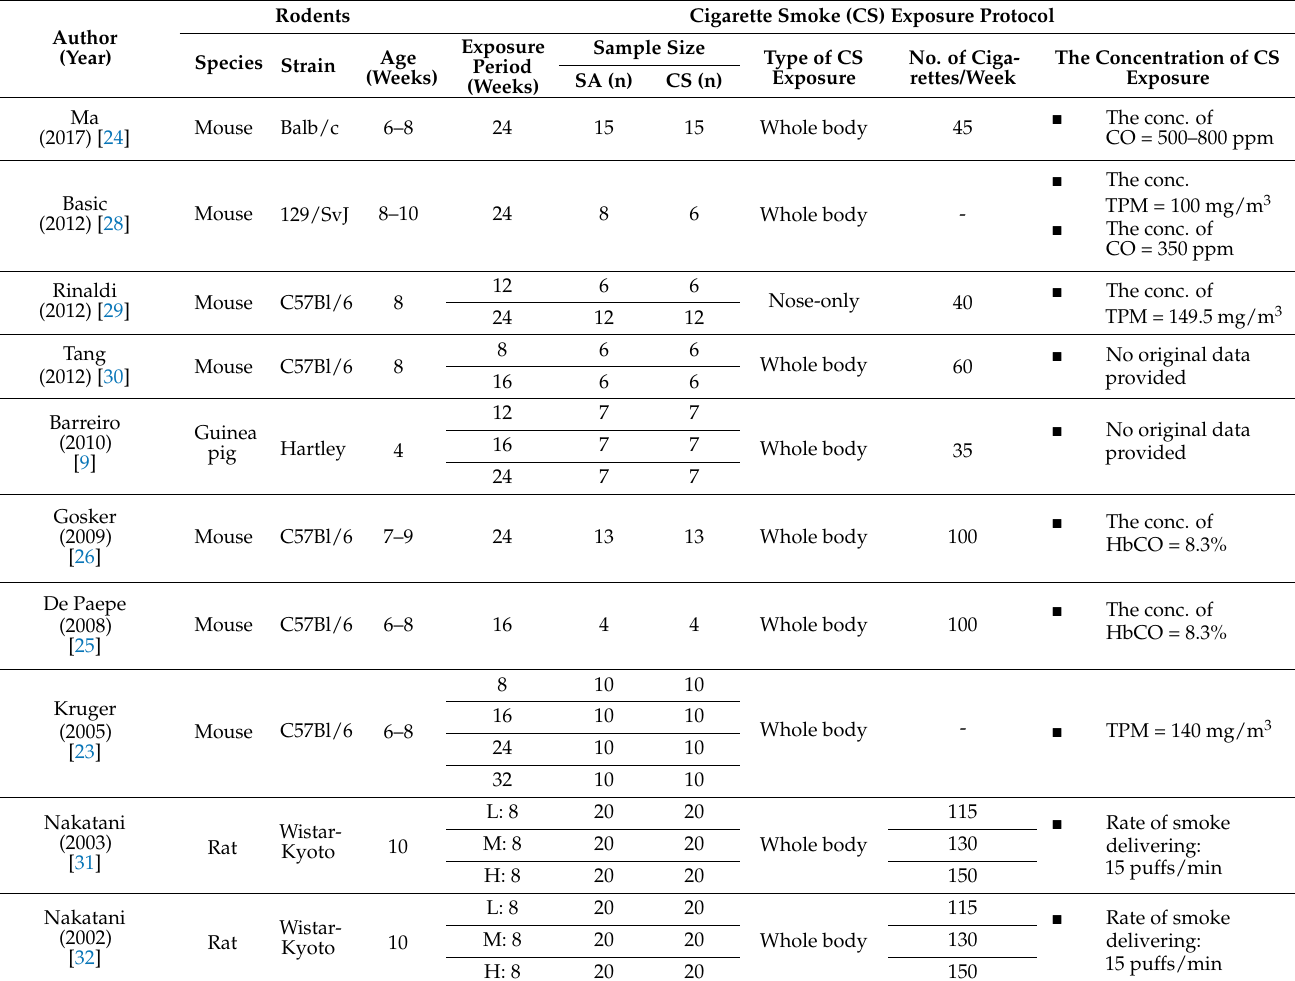
Table 2. Studies included and CS exposure